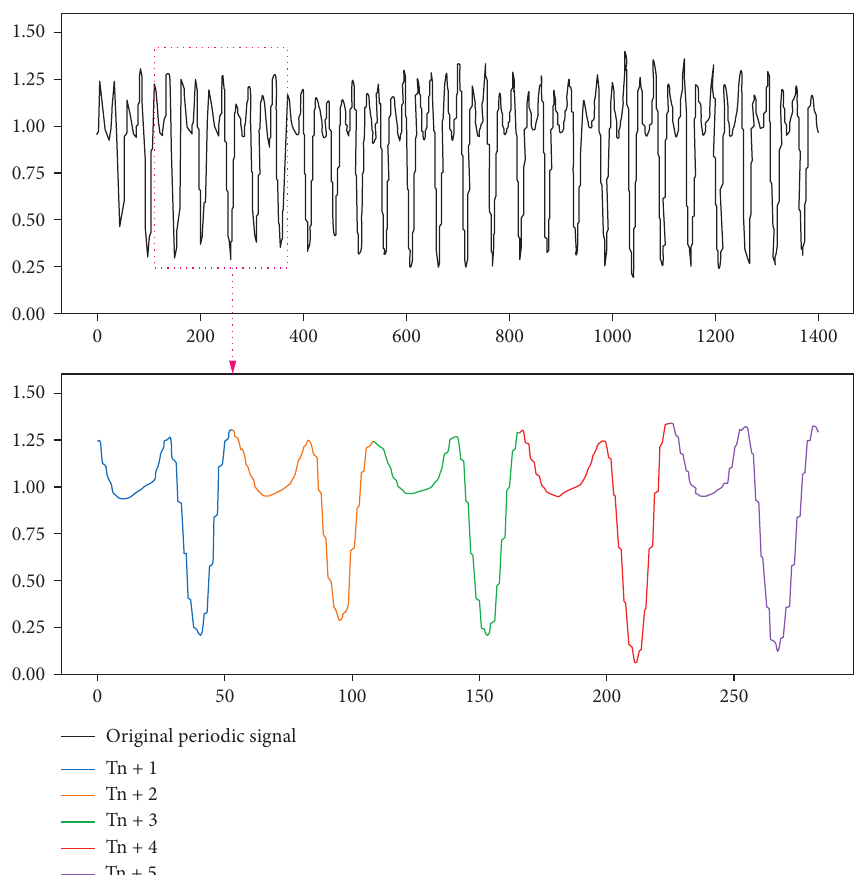
Figure 4: Example of periodic signal extraction results. Periodic signals Tn +1, Tn +2, Tn +3, Tn+4, and Tn +5 are extracted from the pink box of original periodic signal using Pearson’s correlation coefficient and P